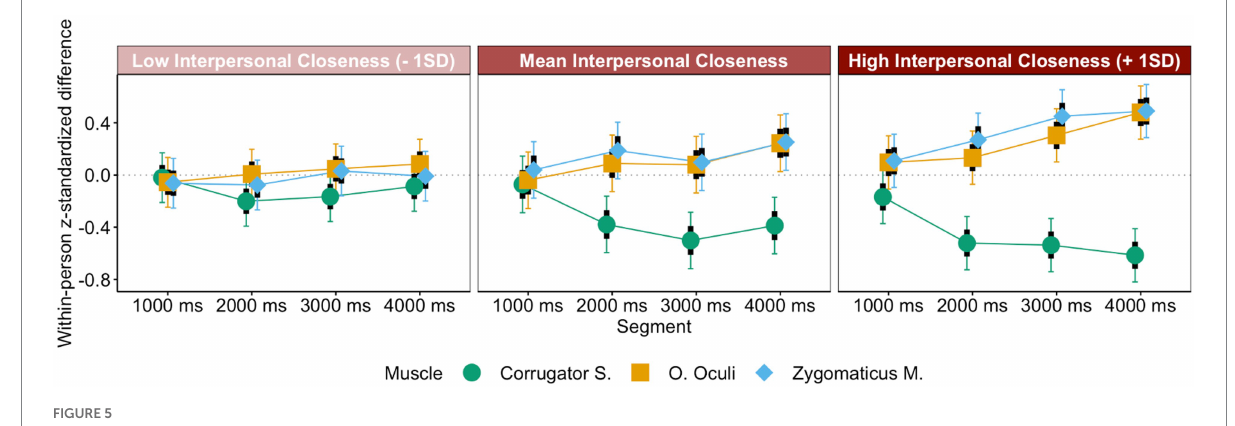
FIGURE 5 Happiness mimicry as a function of interpersonal closeness, segment, and